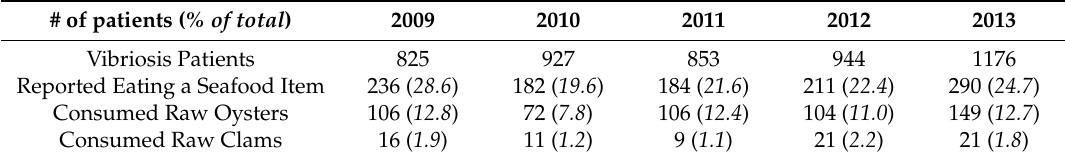
Table 1. Number of vibriosis patients who reported eating seafood, consumed raw oysters, or raw clams in the United States (2009–2013) [28–32]. # of patients ( % of total